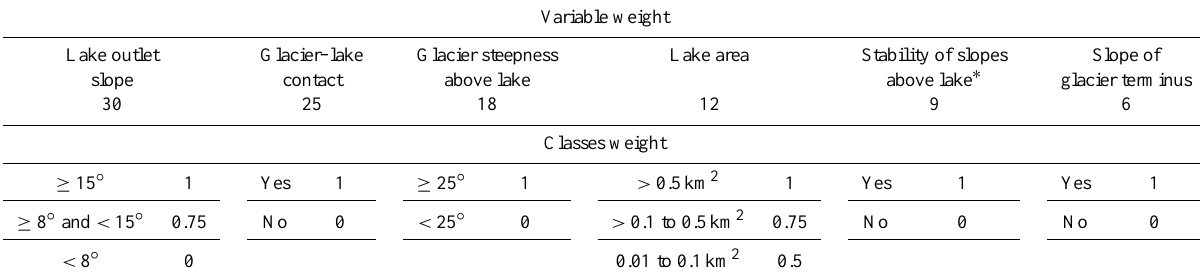
Table 4. Weight of variables associated with moraine-dammed lake failures.